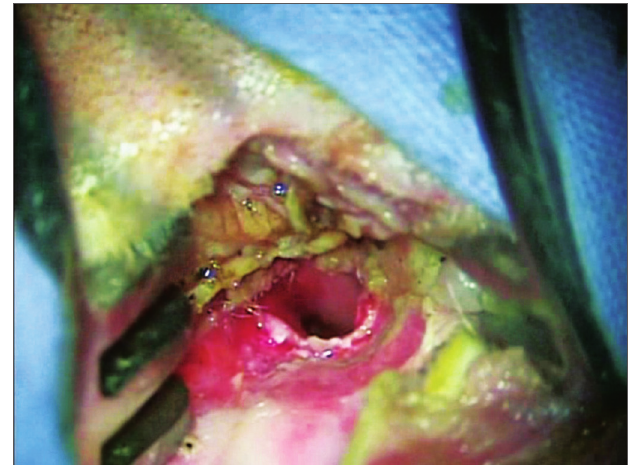
Figura 1. Acesso endaural.